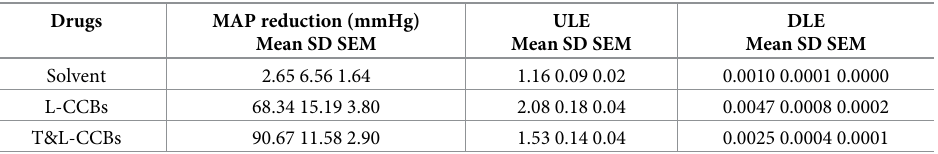
Table 2. Details of MAP reductions and edema for each drug delivery